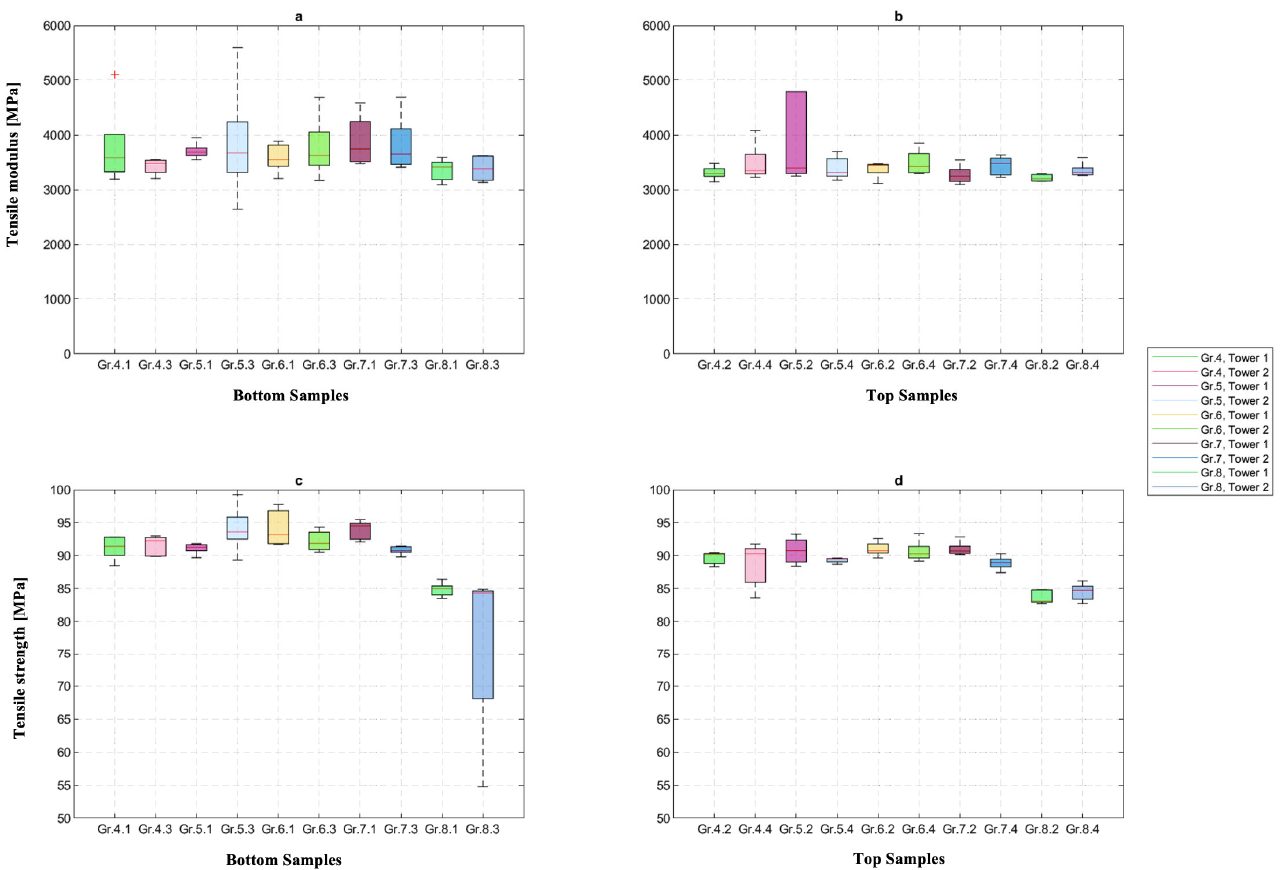
Figure 7. Tensile modulus of the ( a ) bottom samples and ( b ) top samples as well as the tensile strength of the ( c ) bottom and the ( d ) top samples of groups 4–8.